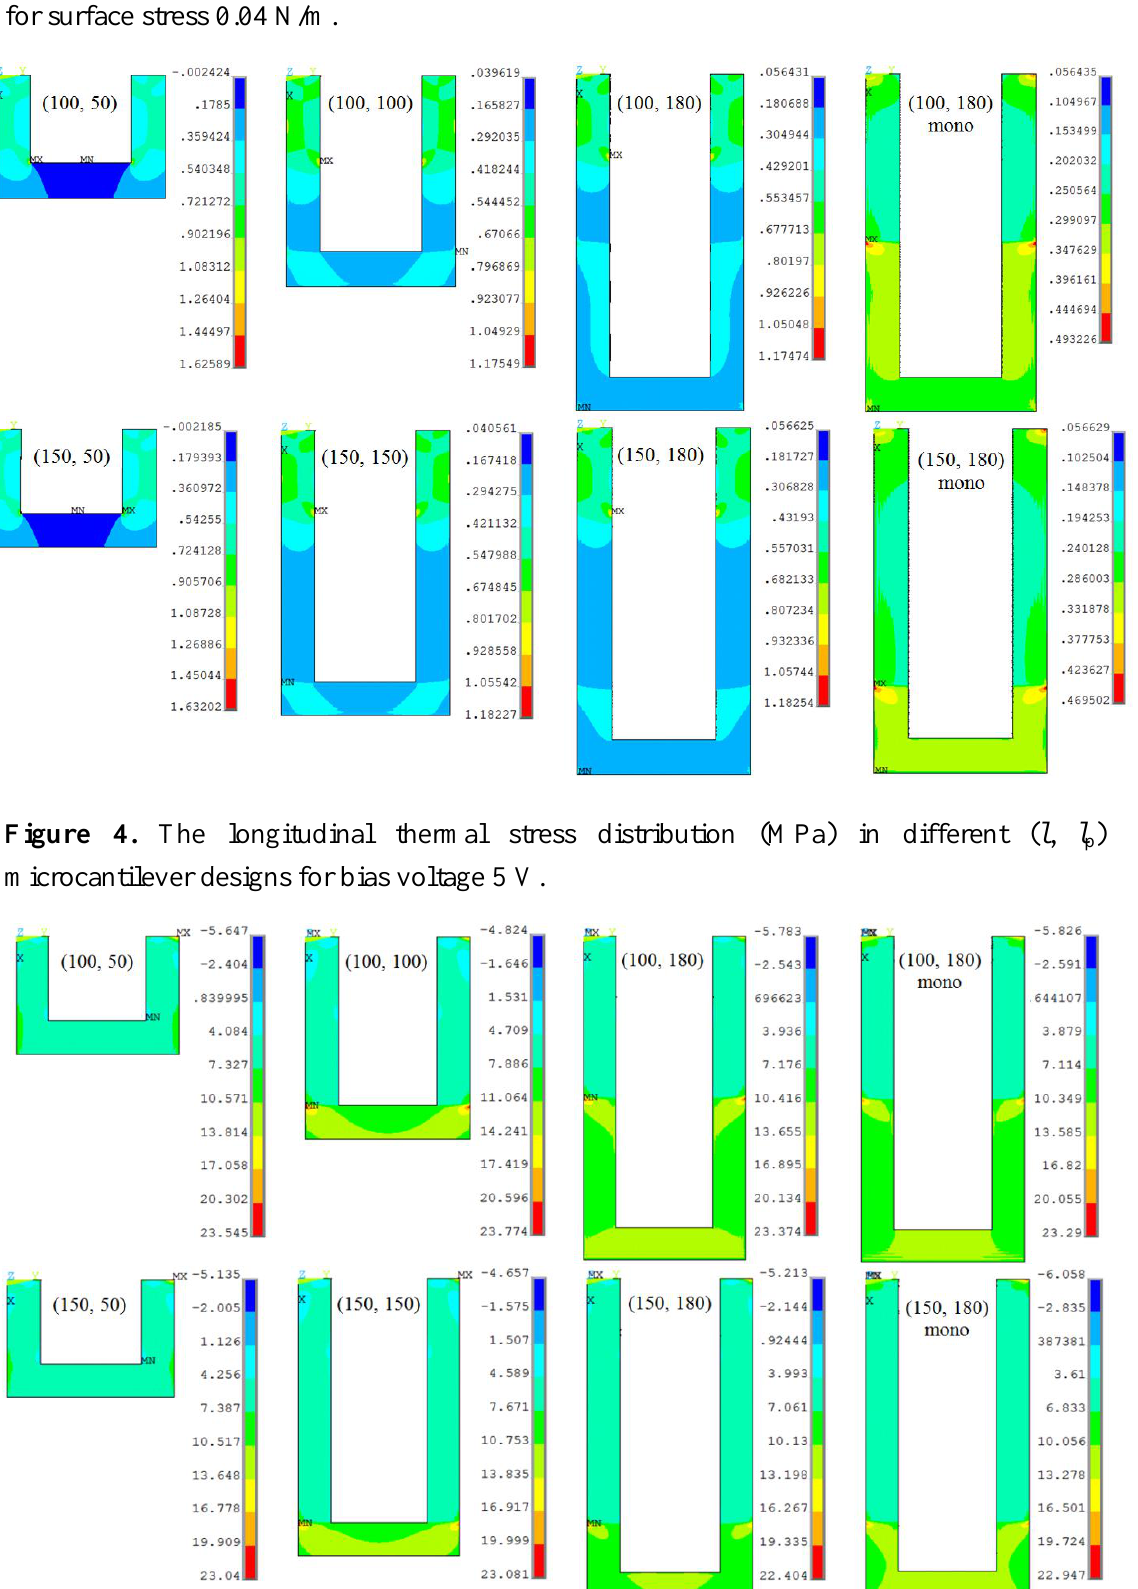
) piezoresistor designs p